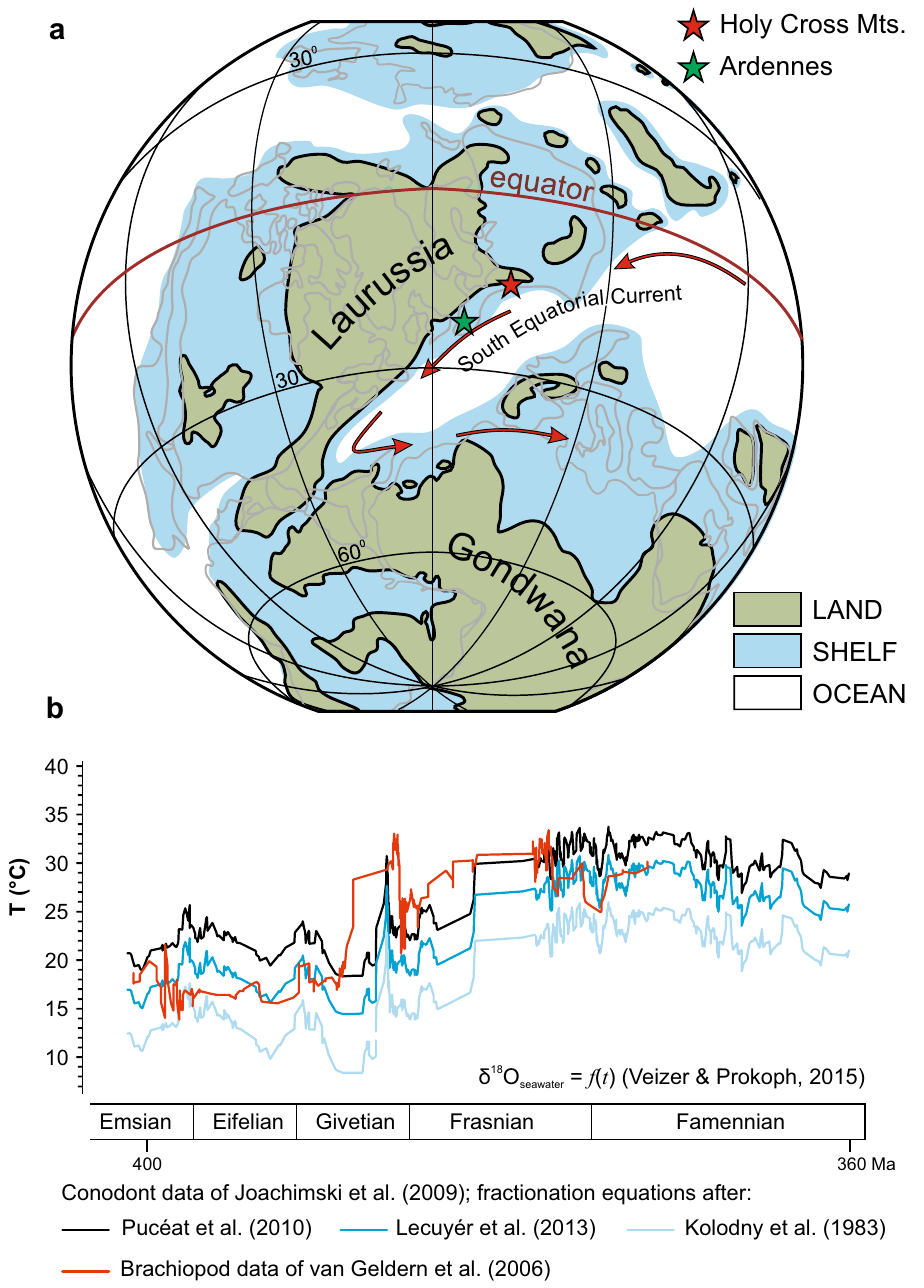
Figure 1. Location of Ardennes and the Holy Cross Mountains on the Devonian palaeogeographic map ( a ), redrawn from Jakubowicz et al. (2019); changes in temperatures across the Middle and Late Devonian ( b ), redrawn from Zapalski et al. (2017) 11 . Palaeogeographic map originally based on Scotese